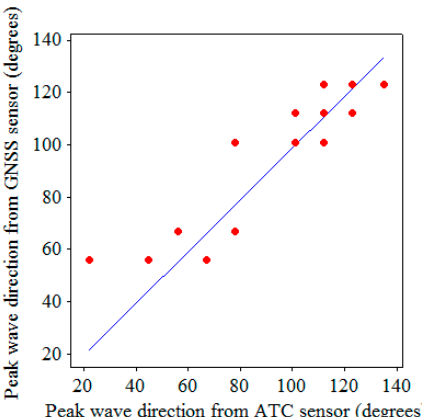
Figure 12. Scatter plot and regression line for the dominant wave directions.